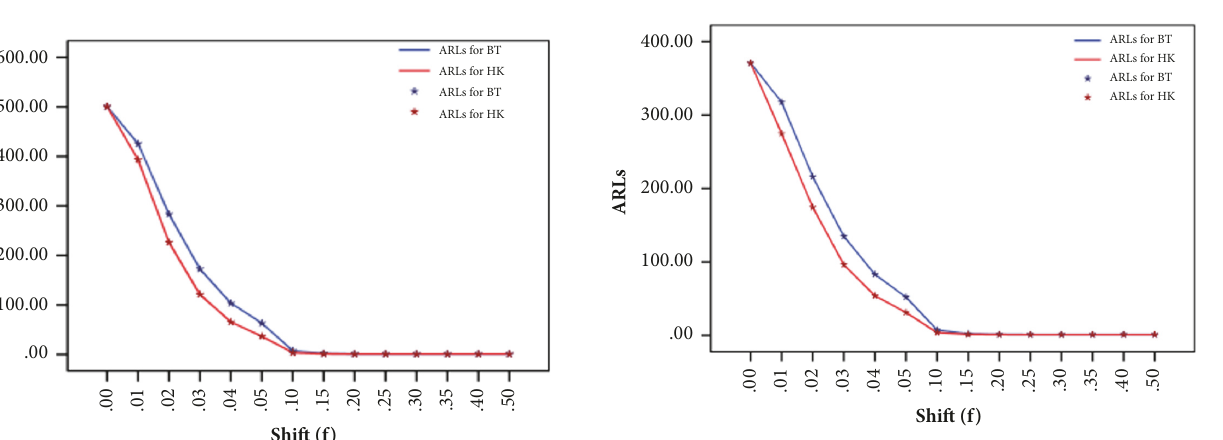
Figure 16: ARLs for proposed repetitive EWMA-RSS control charts using ratio estimators, for 𝜌 = 0.25 when 𝑟 𝑜 = 370 at 𝜆 = 0.1.